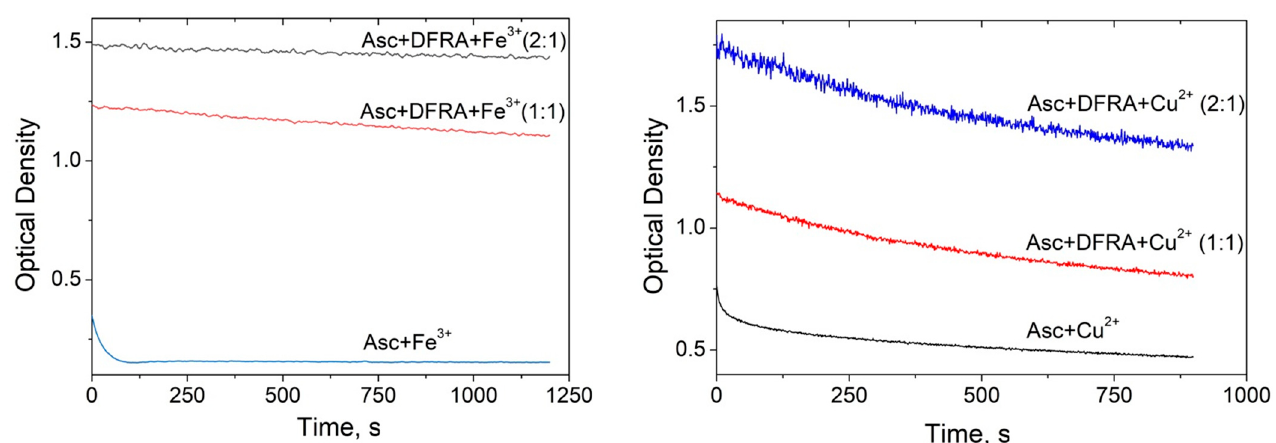
Figure 3. Changes in the rate of oxidation of ascorbic acid (Asc) in the presence of deferasirox (DFRA) Fe and Cu complexes. Time profile changes of the optical density of Asc at 262 nm (0.1 mM in EtOH) in the presence of FeCl 3 (0.05 mM), and CuCl 2 (0.02 mM) and various concentrations of DFRA (0, 0.05 and 0.1 mM for experiments with FeCl 3, left ), and DFRA (0, 0.02 and 0.04 mM for experiments with CuCl 2 , right ). Table 1. The rate constants of the reactions of ascorbic acid (Asc) with Fe 3+ and Cu 2+ ions and their deferasirox (DFRA) complexes calculated from data from Figure 3. The concentration of Asc in both cases was 0.1